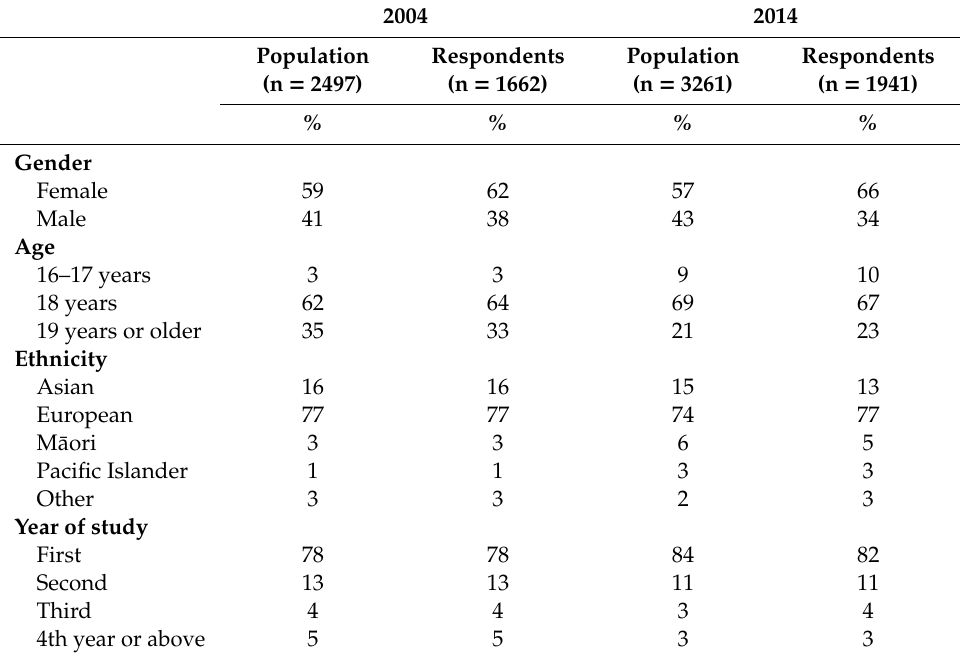
Table 1. Demographic characteristics of the residential college population and respondents in 2004 and